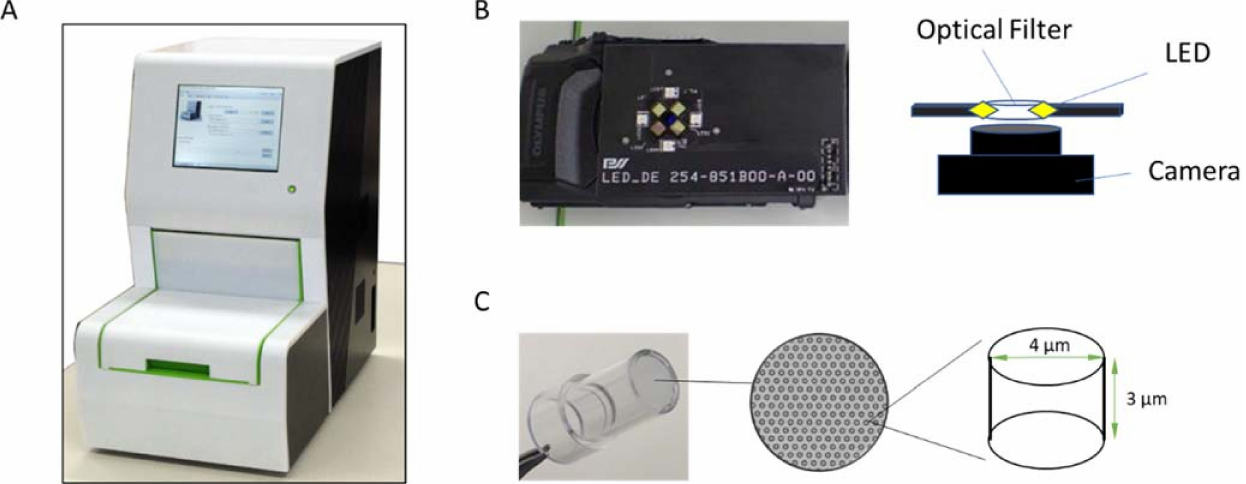
Figure 1. The desktop analyzer and digital device. ( A ) The desktop analyzer. ( B ) Illumination and detection system equipped with a desktop analyzer. ( C ) The digital device, micro-well, and image of the